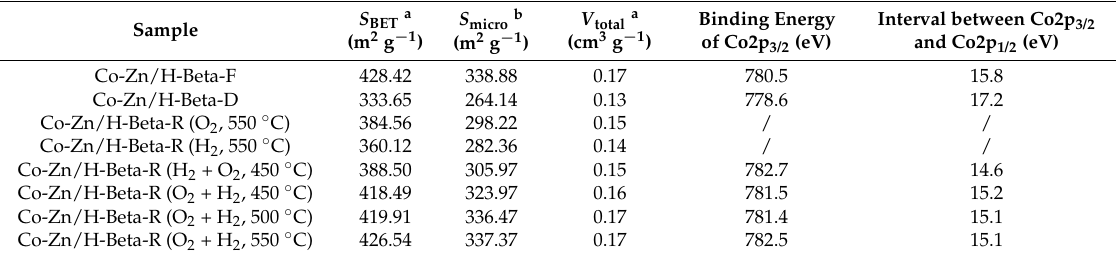
Table 1. Textural properties and X-ray photoelectron spectroscopy (XPS) results of samples.